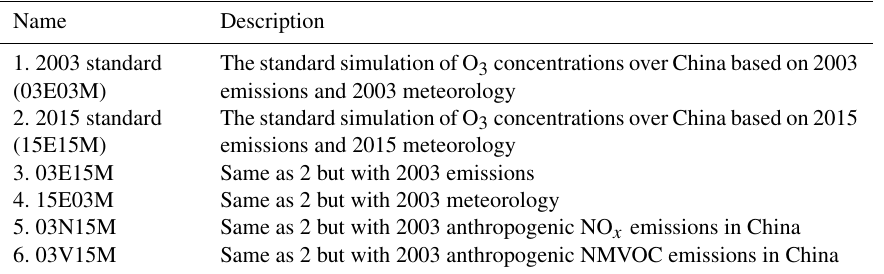
Table 1. Model simulation scenarios in this